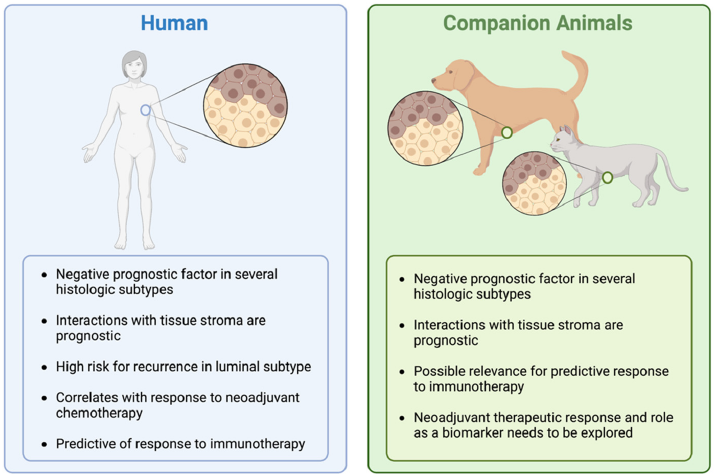
Figure 4. Comparative similarities of TIL evaluation in human and companion animal breast cancer. Several similarities exist between species, including immune checkpoint expression of TILs; however, further evidence is required in companion animals to elucidate the role of TILs as a